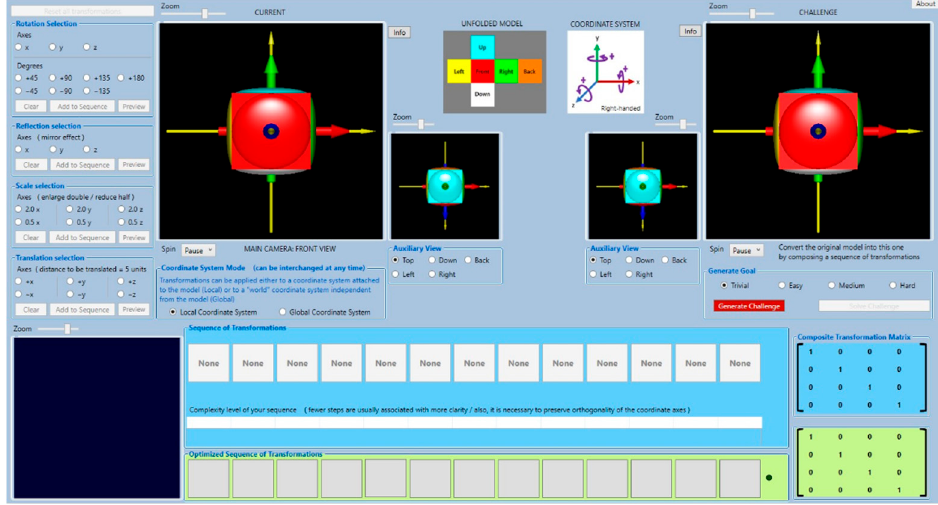
Figure 12. GTV interface.